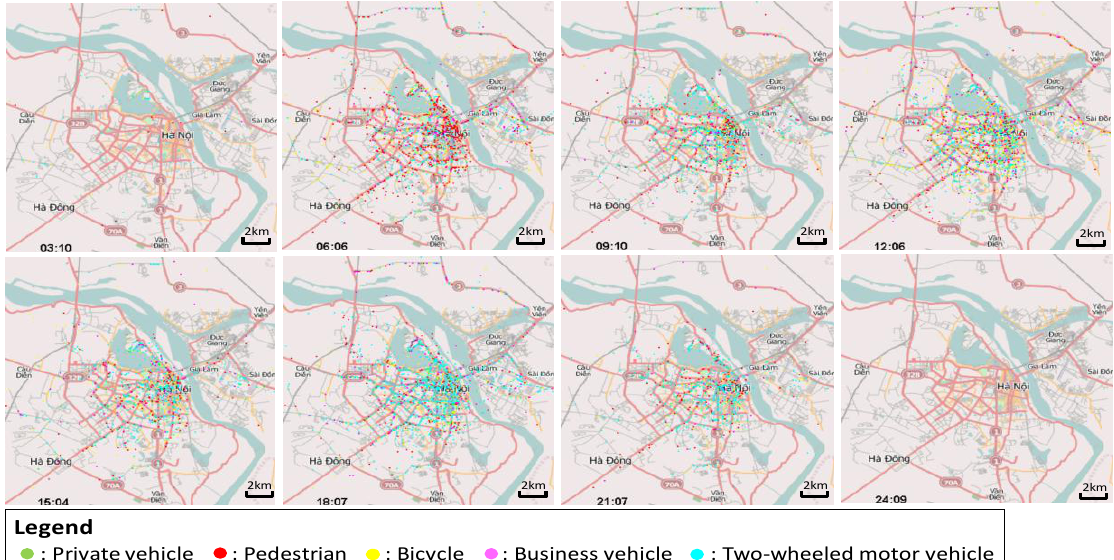
Figure 9. Transition images taken every three hours in